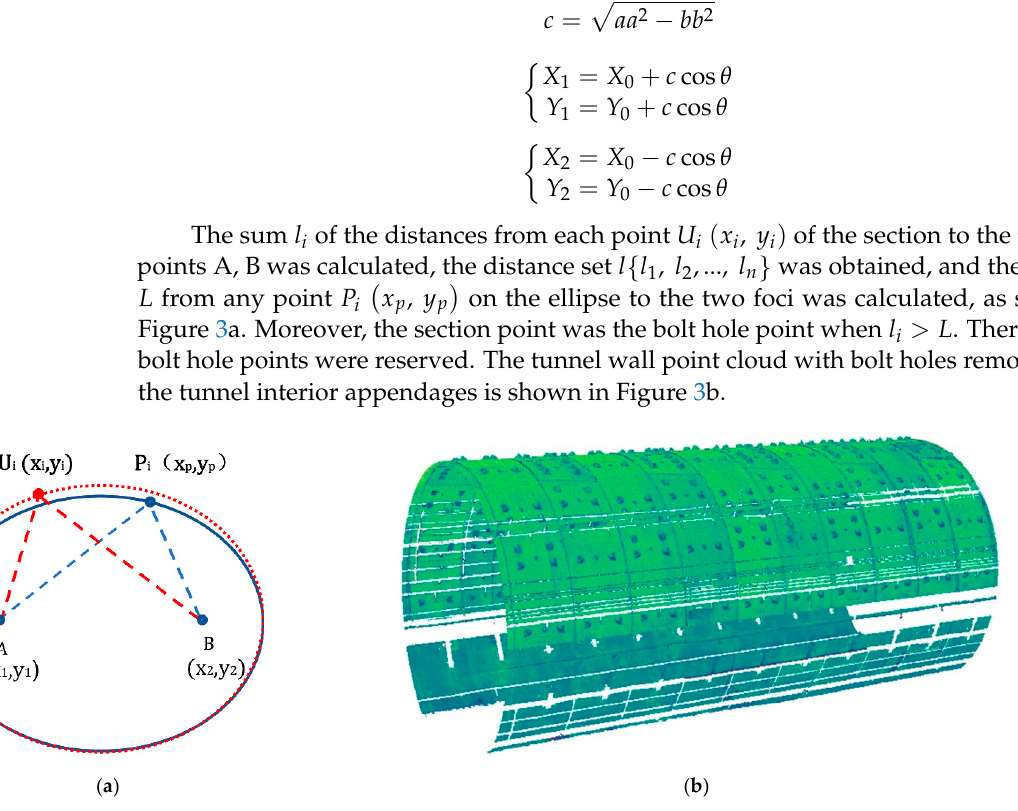
Figure 3. Effect drawings of: ( a ) Bolt hole point determination and ( b ) internal tunnel accessories removal.